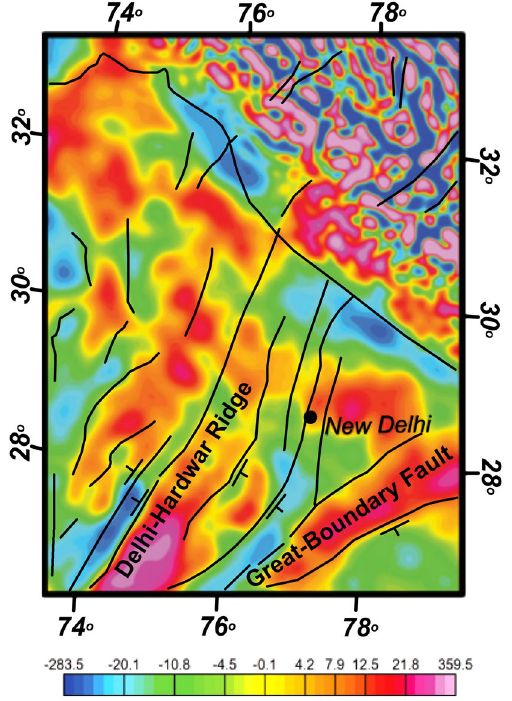
Figure 3. Bouguer gravity map (in Gal) of Delhi region with lineament interpretation and dip directions (modified after Goddin and Harris 39 Harris 33